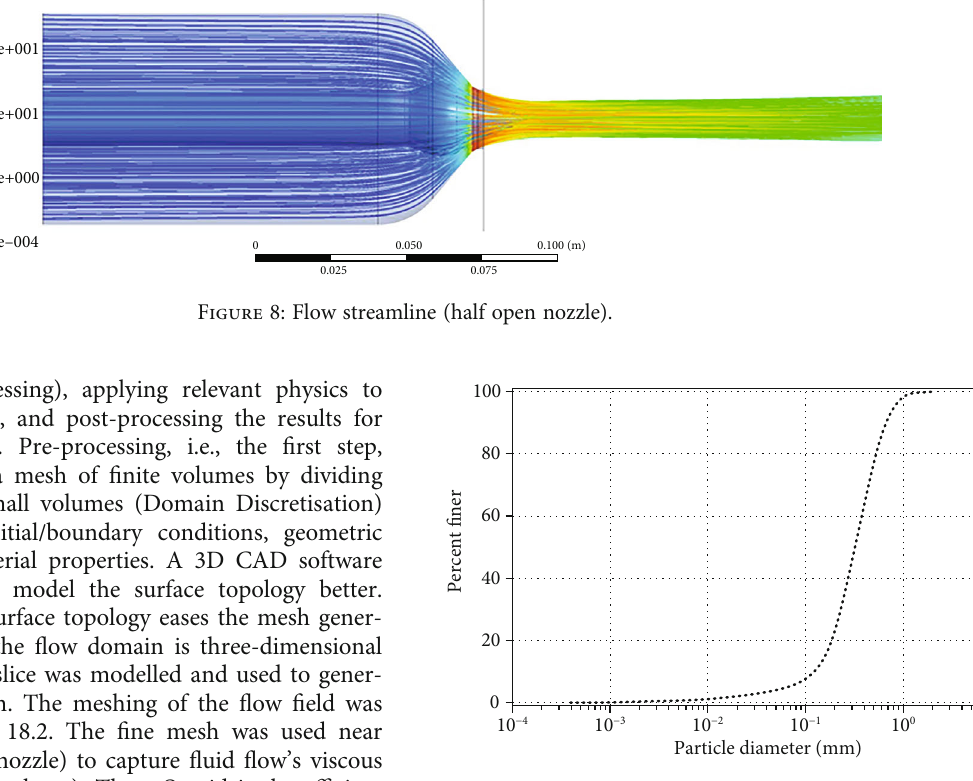
Figure 9: Particle size distribution of sand sample. Table 3: Mineral content